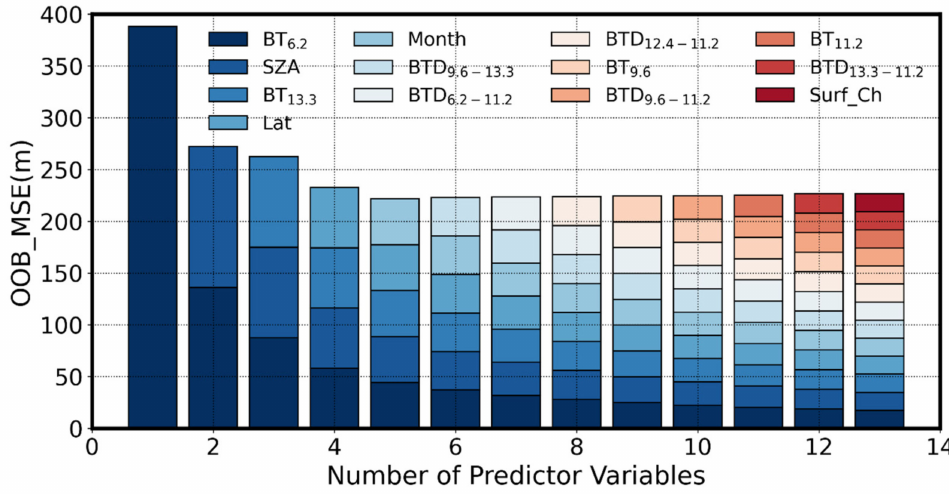
Figure 4. OOB_MSE as a function of the number of variables in subsets which are represented in each column; all variables are ranked with regards to their importance in descending order, and variables with less importance are along with warmer